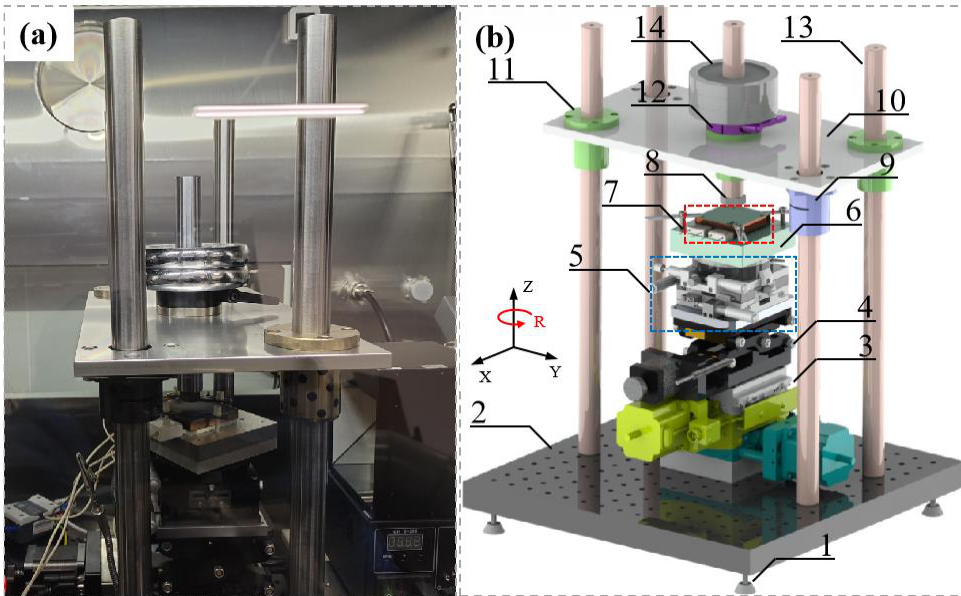
Figure 1. ( a ) Assembly of the novel rapid hot embossing tool. ( b ) 3D model of the novel rapid hot embossing tool. (1) Leveling foot; (2) optical table; (3) XY tilting stage; (4) motorized vertical stage; (5) XYR positioning stage; (6) mica plate; (7) rapid heating module; (8) spherical indenter; (9) fixed collar; (10) mounted plate; (11) linear bearing; (12) locking ring; (13) guiding columns; (14) weights.